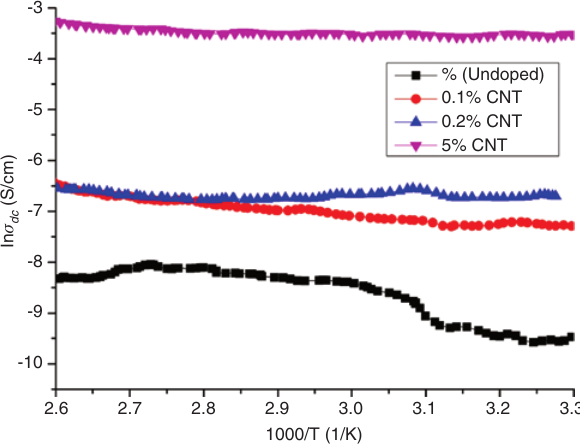
Figure 4 Temperature dependent of the electrical conductivity of undoped and CNT-reinforced ZnO composites.